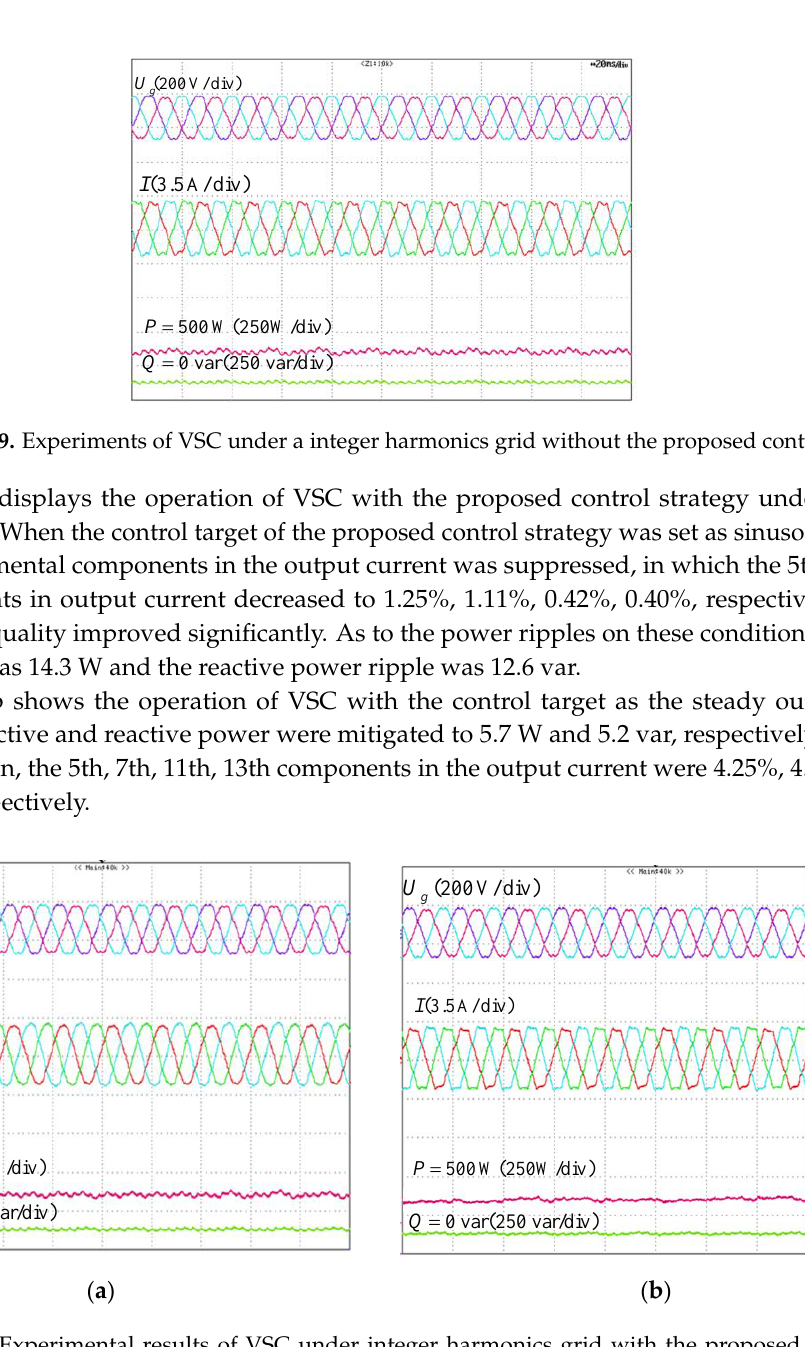
( b ) Figure 11. Power regulation of VSC under integer harmonics grid with the proposed control. ( a ) Power regulation with the target I; ( b ) Power regulation with the target II. For validating the availability of the strategy for inter-harmonics, Figure 12 gives the operation of VSC without the proposed control strategy, when grid voltage contains inter-harmonics. In Figure 12, grid voltage consisted of 288 Hz, 336 Hz, 528 Hz components, which were 3.36%, 3.89%, 1.35%, respectively while the reference of output active power and reactive power was 500 W and 0 var, respectively. When the proposed controller was disabled, the inter-harmonics with 288 Hz, 336 Hz and 528 Hz existed in the output current. The components of the inter-harmonics were 5.61%, 4.24% and 1.46%, respectively, while the ripples in the output power were 21.4 W and 17.5 var.